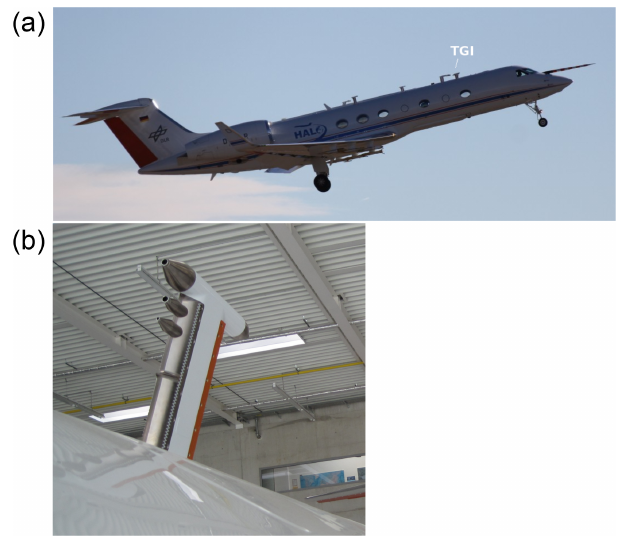
Figure 4. Roof-mounted FISH, HAI, Waran inlet at HALO (photos: a : Andreas Fix, b : Armin Afchine).